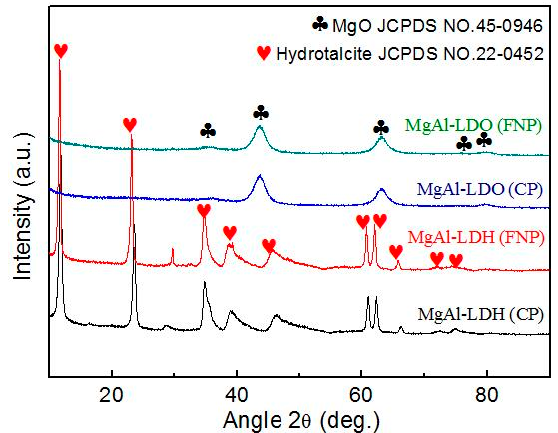
Figure 2. X-ray diffraction (XRD) patterns of MgAl-LDH (CP), MgAl-LDH (FNP), MgAl-LDO (CP), and MgAl-LDO (FNP).